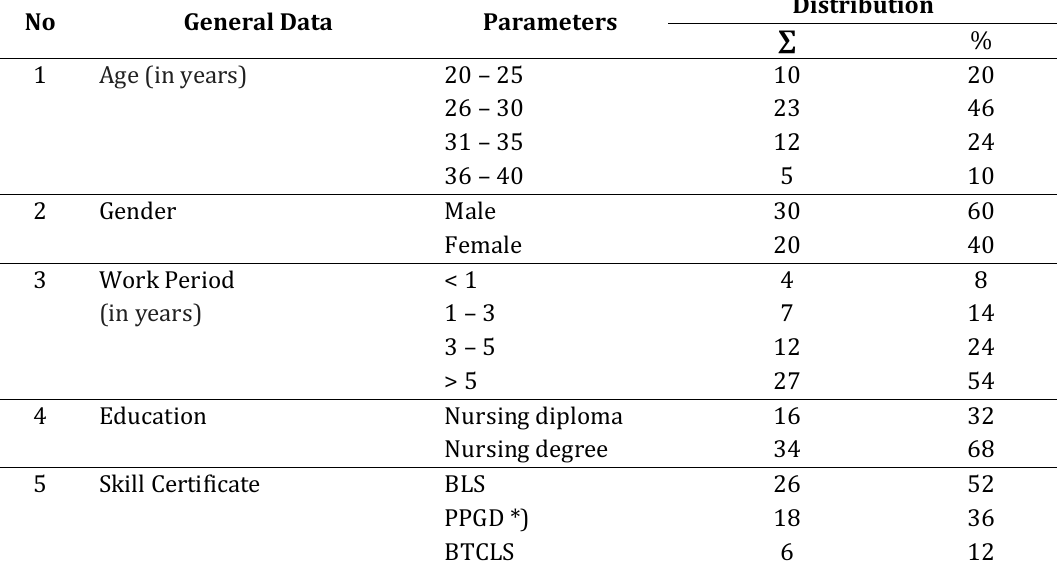
Distribution of respondent characteristics Phase